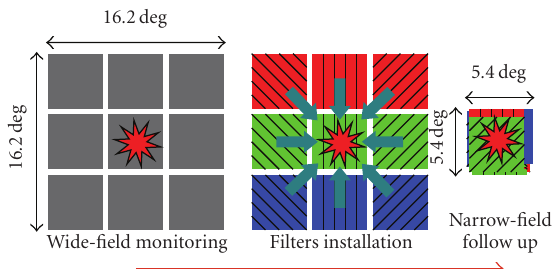
Figure 9: Di ff erent modes of operation of MegaTORTORA system. Left: wide-field monitoring mode in a white light. Middle: insertion of color and polarization filters as a first step of follow-up routine upon detection of a transient. Right: repointing of all unit objectives towards the transient. In the latter regime of operation the system collects three-color transient photometry for three polarization plane orientations (illustrated by a di ff erent stroke directions in figure) simultaneously. Mode transition speed depends on exact hardware parameters (objective and CCD weight, motors used, etc.), but is expected to be less than 0.3 seconds.